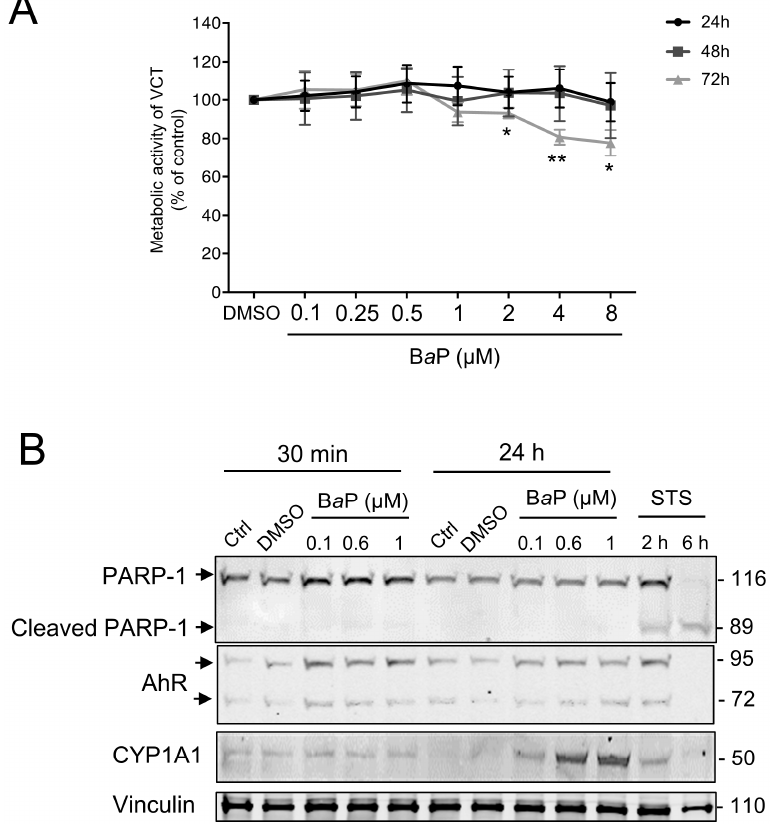
Figure 1. Effect of increasing concentrations of benzo(a)pyrene on human primary trophoblast metabolic activity and AhR pathway activation. Villous cytotrophoblasts (VCT) purified from term placentas were plated overnight. They were then either untreated (Ctrl) or incubated with dimethyl sulfoxide (DMSO, solvent control), benzo(a)pyrene (B a P), or cerium dioxide nanoparticles (CeO 2 NP) at the indicated concentrations for 30 min, 24 h, 48 h, or 72 h. ( A ) WST-1 assay showing metabolic activity of VCT as mean ± SEM ( n = 3) relative to DMSO control for each time of treatment. * p < 0.05, ** p < 0.01 vs. DMSO. ( B ) VCT were also incubated with 0.5 µM of staurosporine (STS) for 2 h or 6 h. Total protein extracts were subjected to SDS-PAGE under reducing conditions and membranes were immunoblotted with anti-PARP-1, anti-AhR, anti-CYP1A1, and anti-vinculin antibodies (the latter was used as loading